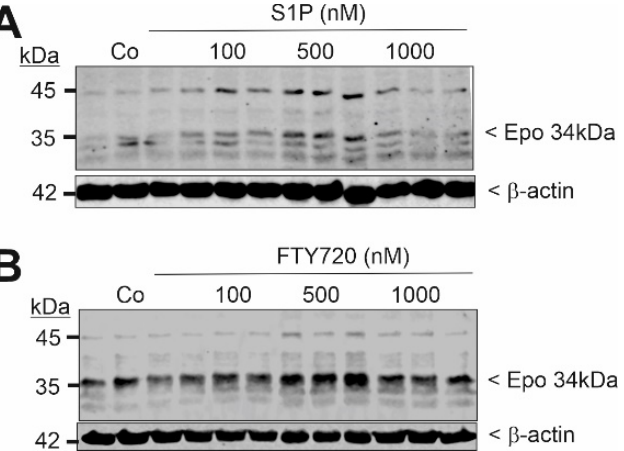
Figure 5. Effect of S1P and FTY720 on Epo protein expression in the human neuroblastoma cell line Kelly. Confluent Kelly cells were incubated for 16 h with serum-free DMEM prior to stimulation for 6 h with either vehicle (Co) or the indicated concentrations of S1P ( A ) and FTY720 ( B ). Thereafter, protein extracts were prepared and taken for protein separation by SDS-PAGE, transferred to nitrocellulose membranes, and subjected to Western blot analyses using antibodies against Epo and β -actin. Blots show one representative experiment performed in triplicates. Bands corresponding to 34 kDa Epo and β -actin were evaluated by Image Studio Lite software and the results are depicted in Supplementary Figure S4.